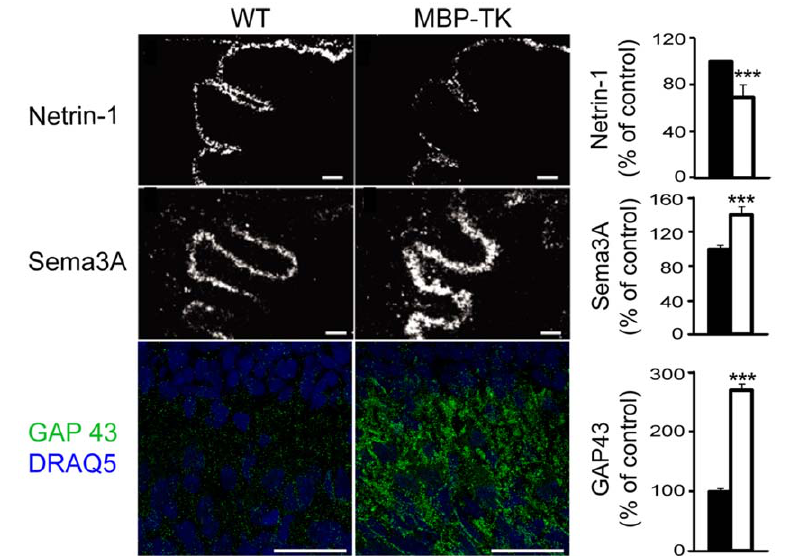
Figure 2. Oligodendrocyte ablation modifies the expression of axonal guidance molecules and neuronal plasticity markers. (A) In situ hybridization with Netrin-1 and Sema3A specific antisense riboprobes in MBP-TK and WT treated littermates in P1 cerebella. Scale bar 100 m m. Quantification (expressed as % of control) of Netrin-1 shows a decrease of its expression in granule cell precursors of the external granular layer; while a concomitant increase of Sema3A expressed by Purkinje neurons is observed in MBP-TK mice versus WT siblings. Values are mean 6 SEM and analyzed by Student’s t-test: ***P , 0.001 (B) Double immunostainings using anti-GAP43 antibody (green) and DRAQ-5 (blue), Scale bar: 25 m m. MBP- TK animals have a higher GAP43 level compare to their WT littermates. Values are mean 6 SEM and analyzed by Mann-Whitney U-test: ***P , 0.001. WT: black bar; MBP-TK: white bar.